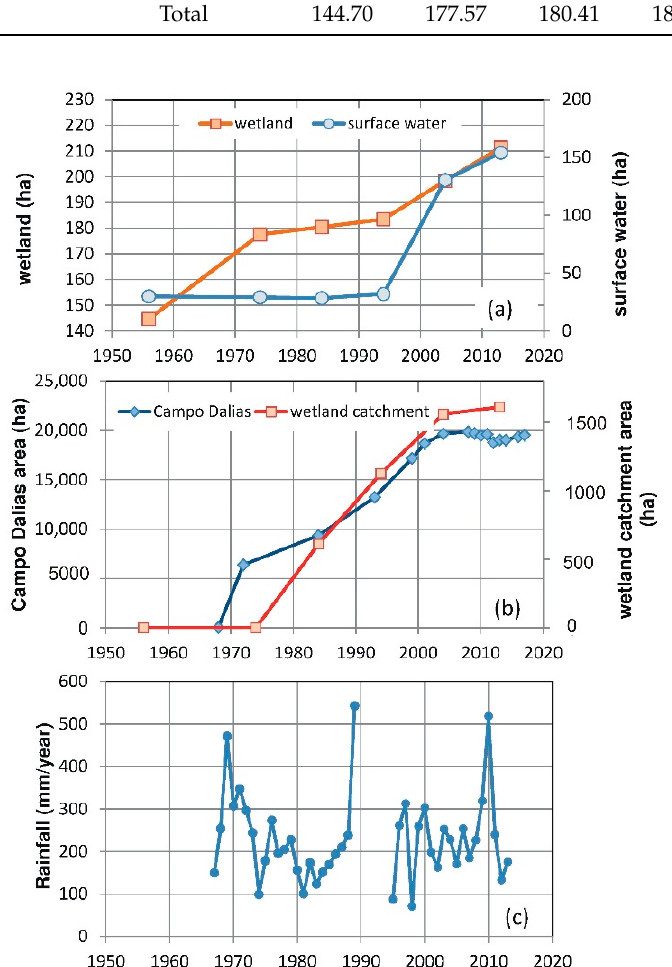
Figure 2. ( a ) Evolution of the total area (hectares) occupied by the wetland including all mapped environments and the area occupied by surface water. ( b ) Evolution of the land area occupied by greenhouses throughout the Campo de Dalías (CD) and in the coastal wetland catchment area. ( c ) Annual rainfall, La Mojonera station.